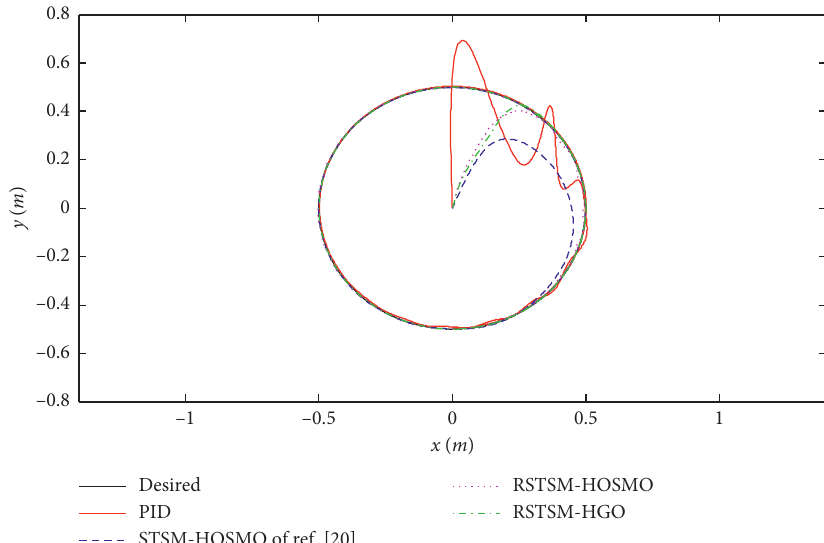
Figure 3: Circular reference trajectory tracking response diagram.